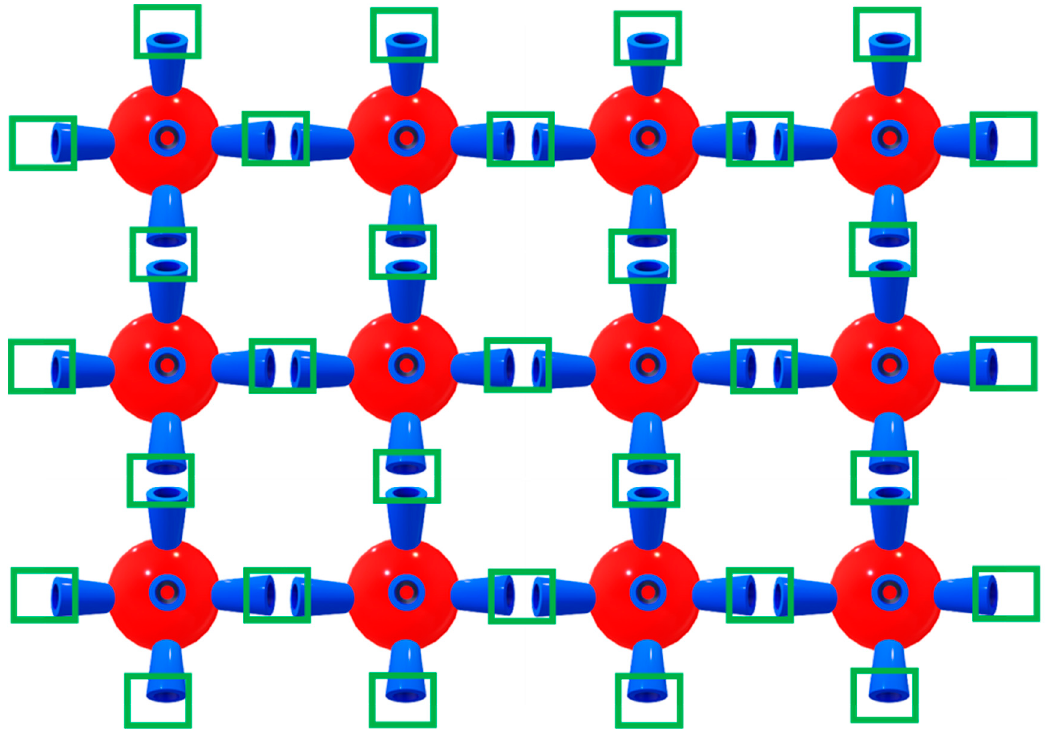
Figure 3. Visualization of the concept of networking of AgNPs due to the structure of beta-cyclodextrin. This can explain the morphology in the TEM image. Red, blue and green colors represent AgNPs, beta-cyclodextrin, and the linkers (hydroxyl groups of beta-cyclodextrin), respectively.